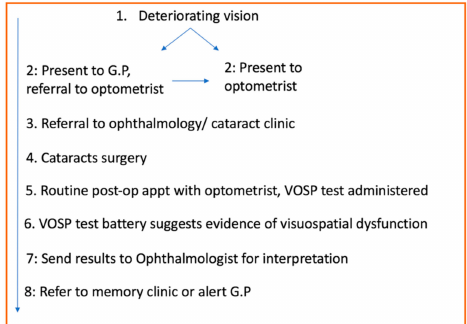
Figure 1. Proposed clinical